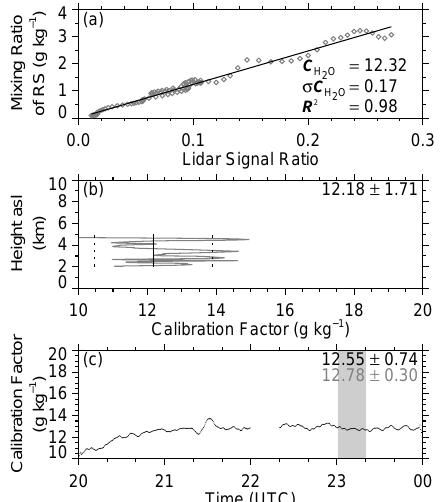
Figure 3. Calibration methods for a clear sky night from a Polly XT measurement on 5 May 2013 (HOPE IOP 12): (a) regression method. Water vapour mixing ratio of the radiosonde (RS) as func- tion of the signal ratio from the lidar averaged over 20min from 23:00 to 23:20UTC. C H is the slope of the regression line, 2 O σC H is the standard error of the slope and R 2 is the coefficient of 2 O determination. (b) Profile method. The calibration factor for each considered height bin. The numbers indicate the mean calibration factor and its standard deviation. (c) IWV method. Time series of the calculated calibration factor (black line). The black numbers de- note the mean and the standard deviation of the whole time range, whereas the grey numbers correspond to the time range of the RS ascent (grey area).